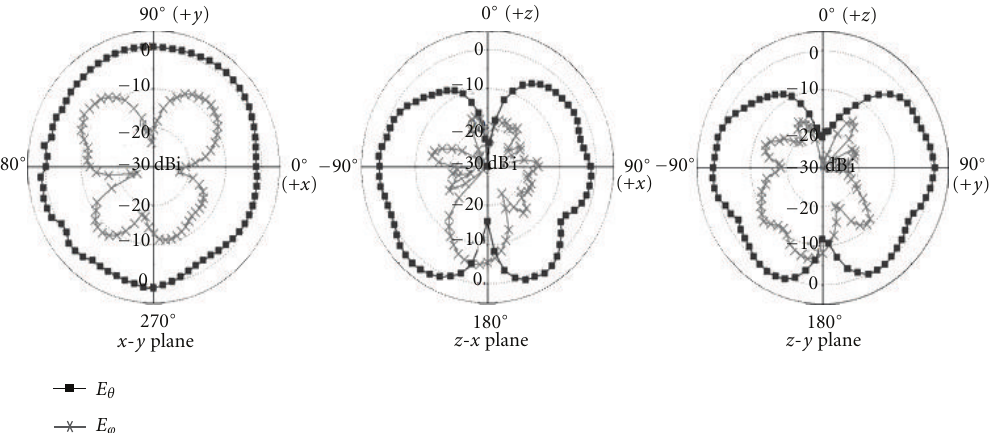
Figure 10: Measured radiation patterns of the monopole.